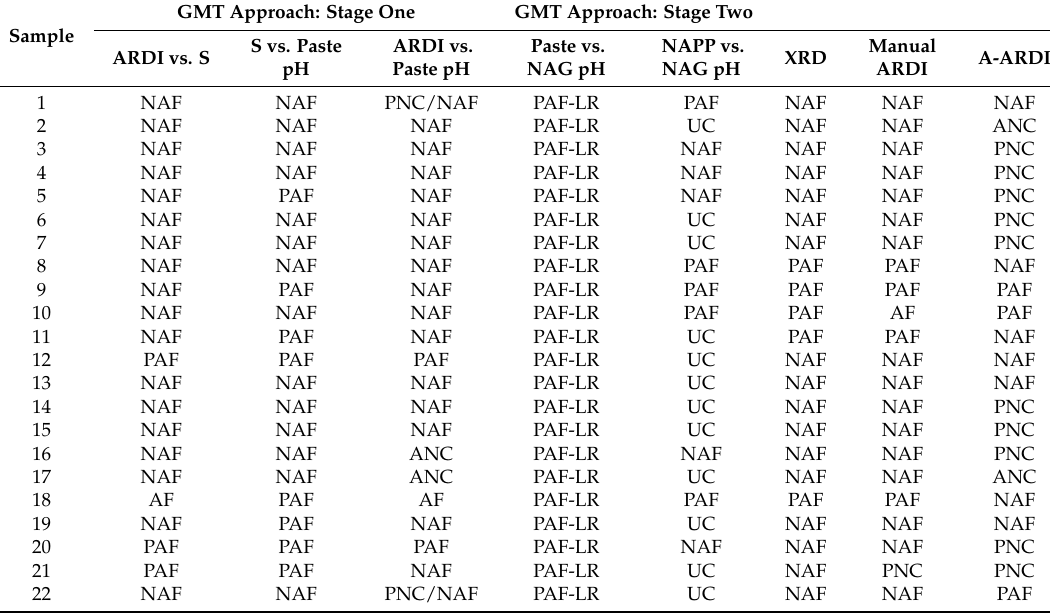
Table 3. Comparison of geochemical, mineralogical and automated ARDI (A-ARDI) classifications (abbreviations: AF, acid forming; ANC, acid neutralizing capacity; NAF, non-acid forming; PNC, potential neutralizing capacity; PAF, potentially acid forming; LR., low risk; UC, uncertain; S, total